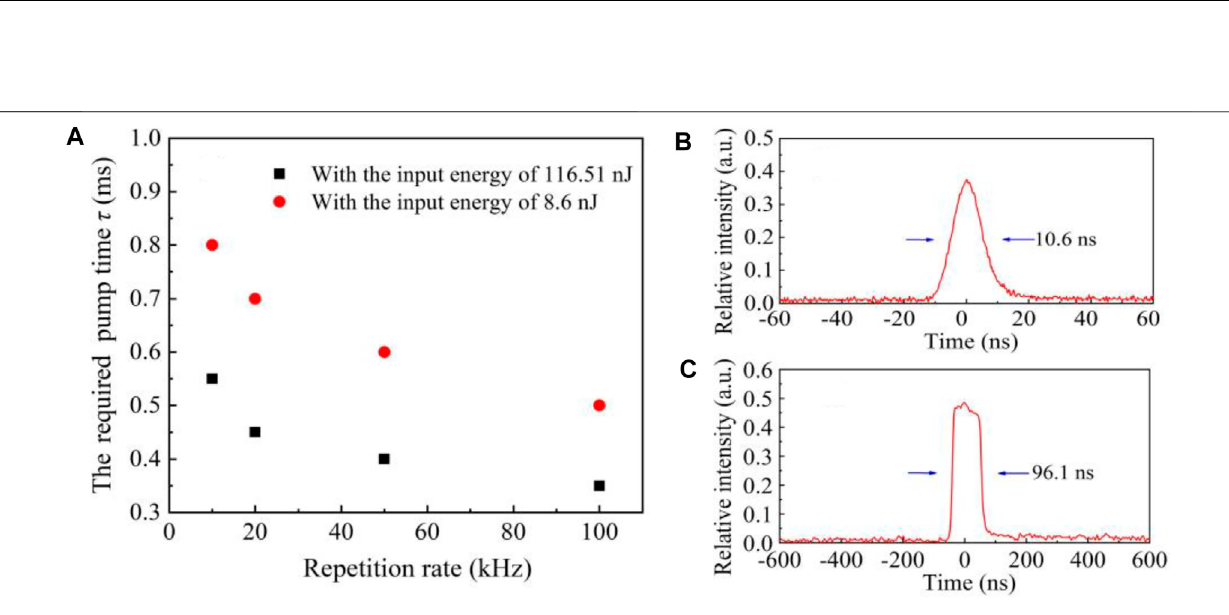
Frontiers in Physics |